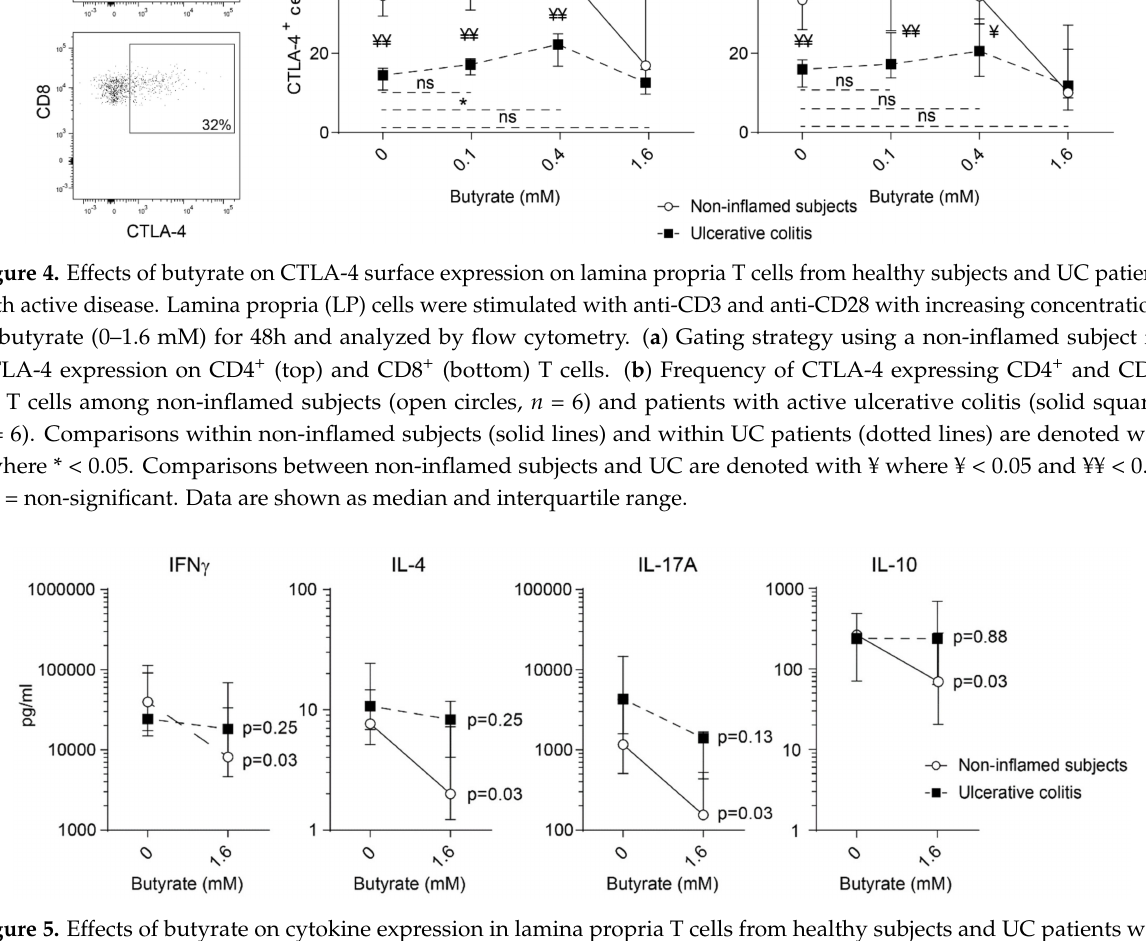
Figure 5. Effects of butyrate on cytokine expression in lamina propria T cells from healthy subjects and UC patients with active disease. Lamina propria (LP) cells were stimulated with anti-CD3 and anti-CD28 and treated with butyrate (1.6 Mm) for 48 h. Cytokine production of IFN γ , IL-4, IL-17A, and IL-10 were analyzed by ELISA and MSD. Data are shown as median and interquartile